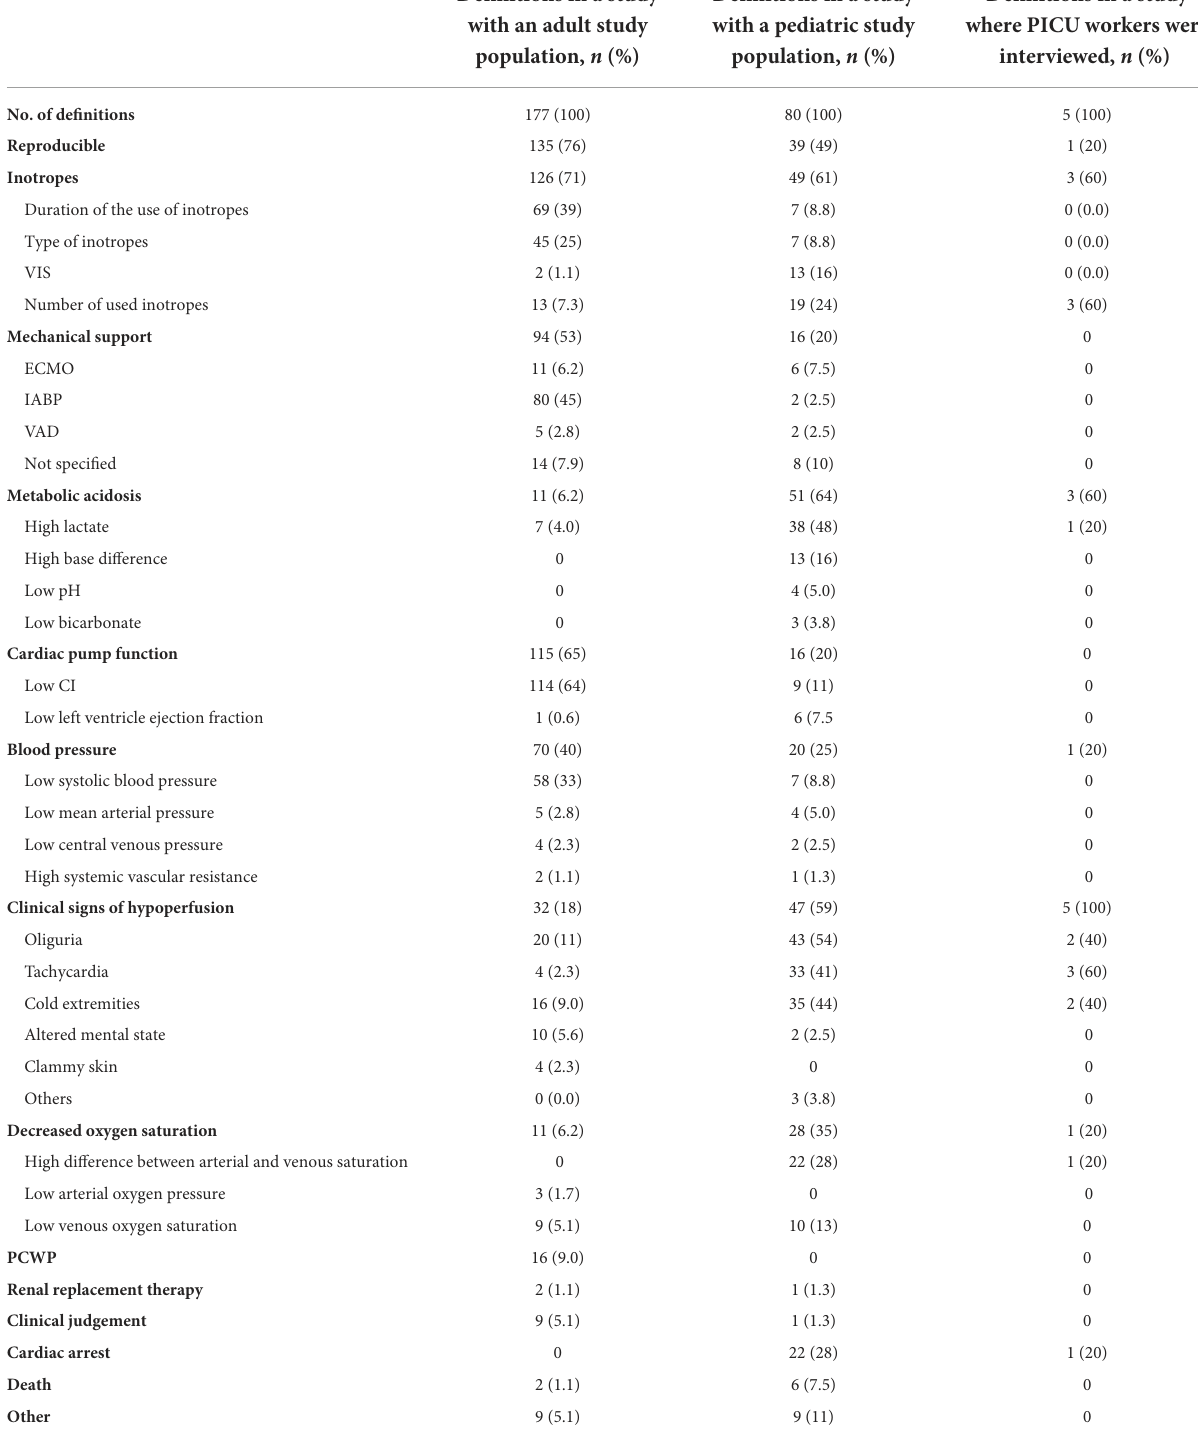
TABLE 1 Variables used in low cardiac output syndrome